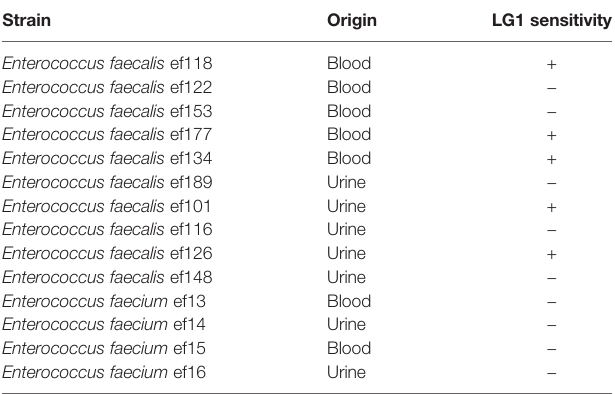
TABLE 1 | The host range of phage LG1.